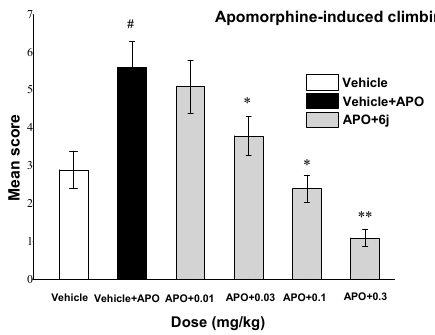
Figure 2. Effect of compound 6j on APO-induced climbing in mice (10/group). The score was shown as means ± SEM. Statistical significances were performed by the nonparametric two-tailed Mann-Whitney U-test: # p < 0.05 vs. vehicle treatment; * p < 0.05 and ** p < 0.01 vs. apomorphine treatment.